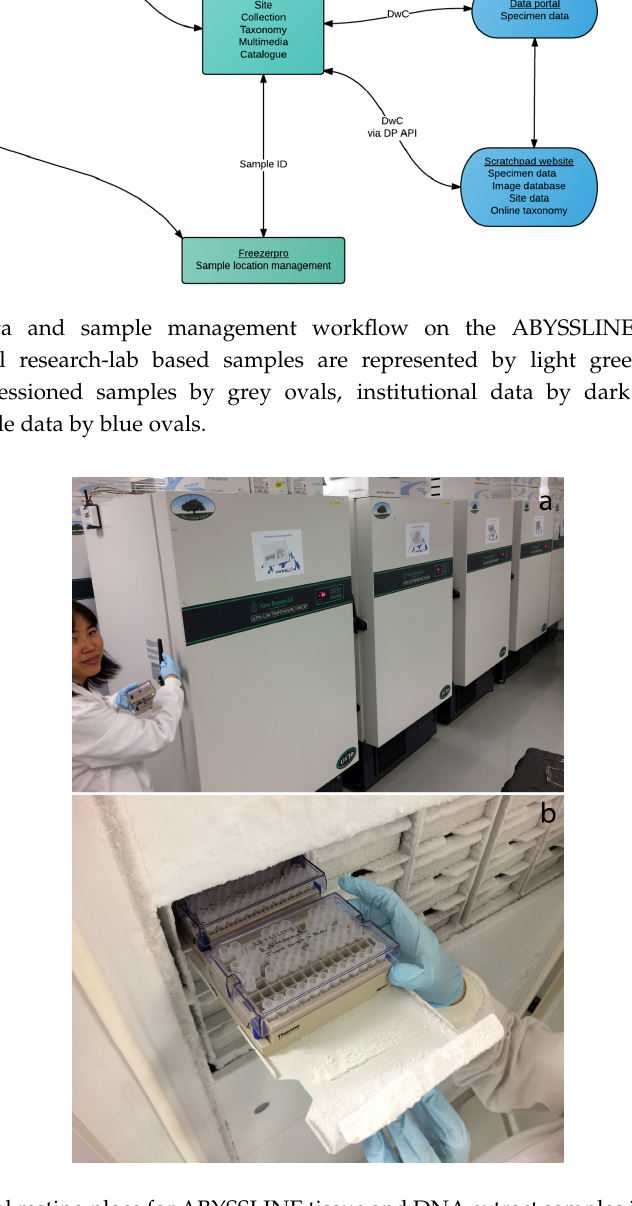
Figure 19. The final resting place for ABYSSLINE tissue and DNA extract samples in the data pipeline is the − 80 °C freezers of the Natural History Museum Molecular Collection Facility. This is a curated facility with multiple freezers connected to backup power systems and emergency notifications of power failures designed for the long-term storage (and ability for researchers to sample) DNA and tissue samples. Here two plates containing echinoderm tissue sample and template DNA are loaded into the freezer “Polar